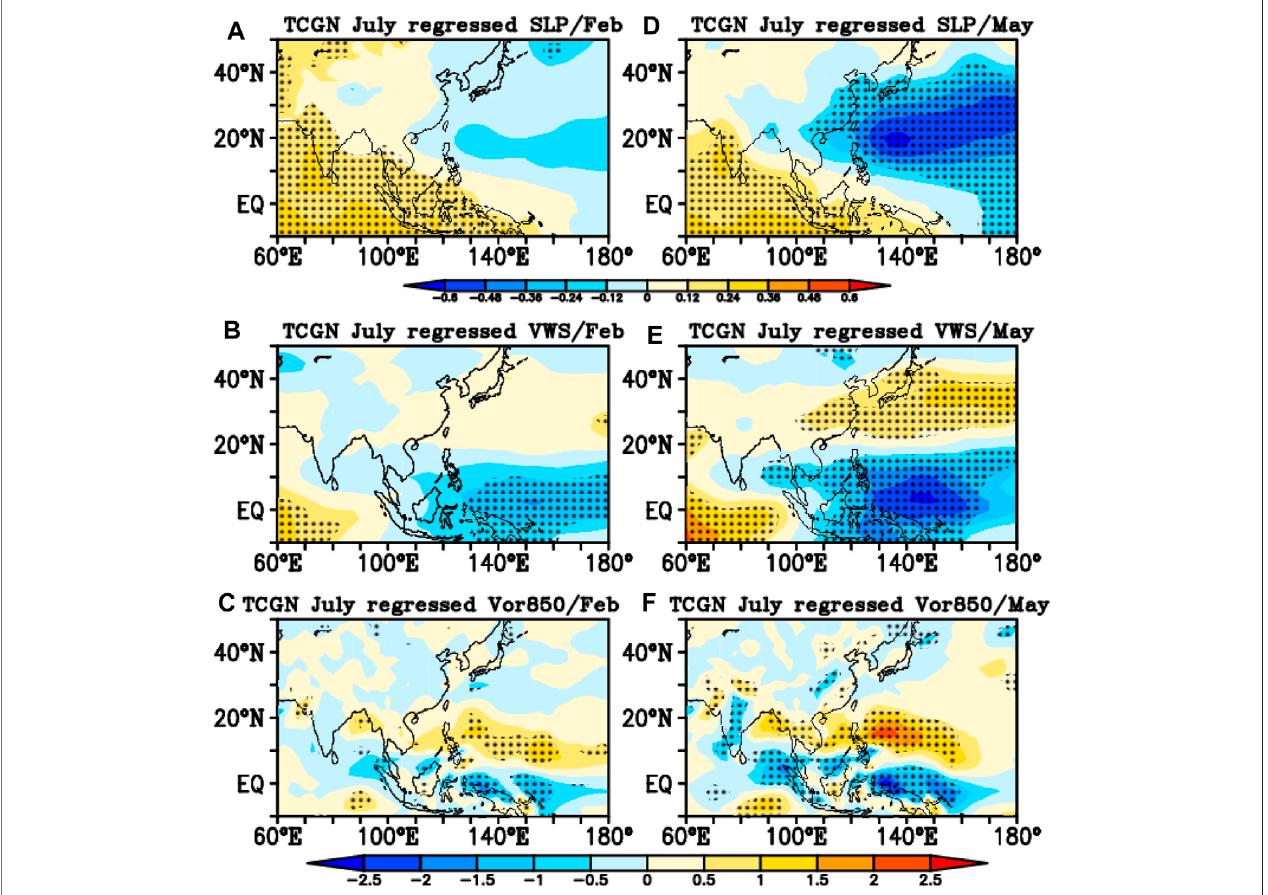
FIGURE 13 | Regression patterns of the CFSv2-predicted July (a, d) SLP anomaly (units: hPa) (b, e) 850-hPa relative vorticity anomaly (units: 10 – 6 s), and (c, f) VWS anomaly between 850 and 200 hPa (units: m/s), at (A – C) 4- and (D – F) 2-months leads, upon the standardized July TCGN during 1982 – 2020. Dotted areas indicate statistical signi fi cance at the 95% level, as estimated by a Student ’ s t -test.